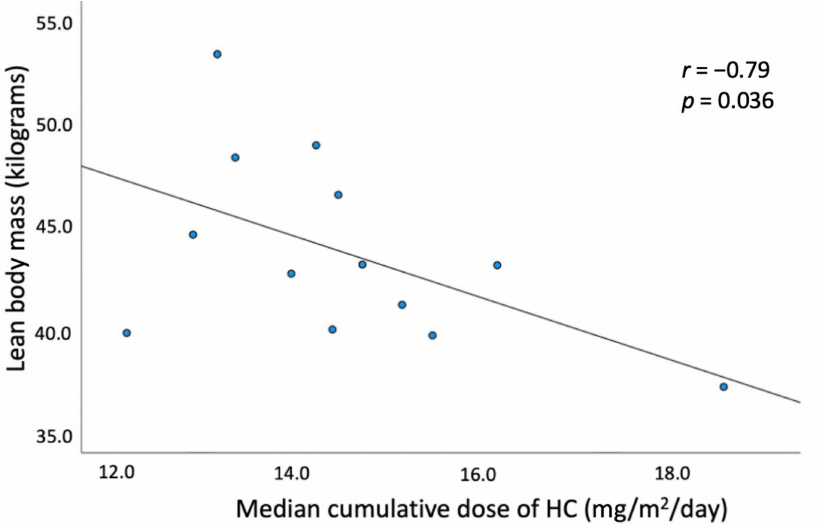
Figure 3. Negative association between HC dose (mg/m 2 /day) and lean body mass (kilograms) in CAH female